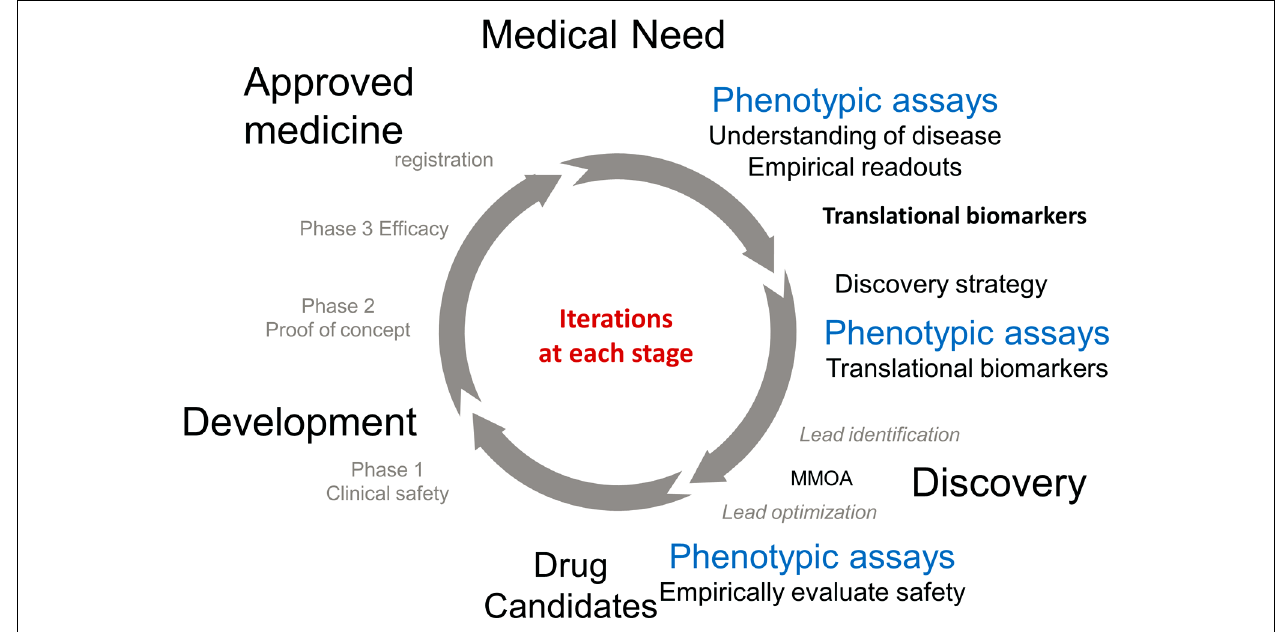
FIGURE 1 | Drug discovery research and development